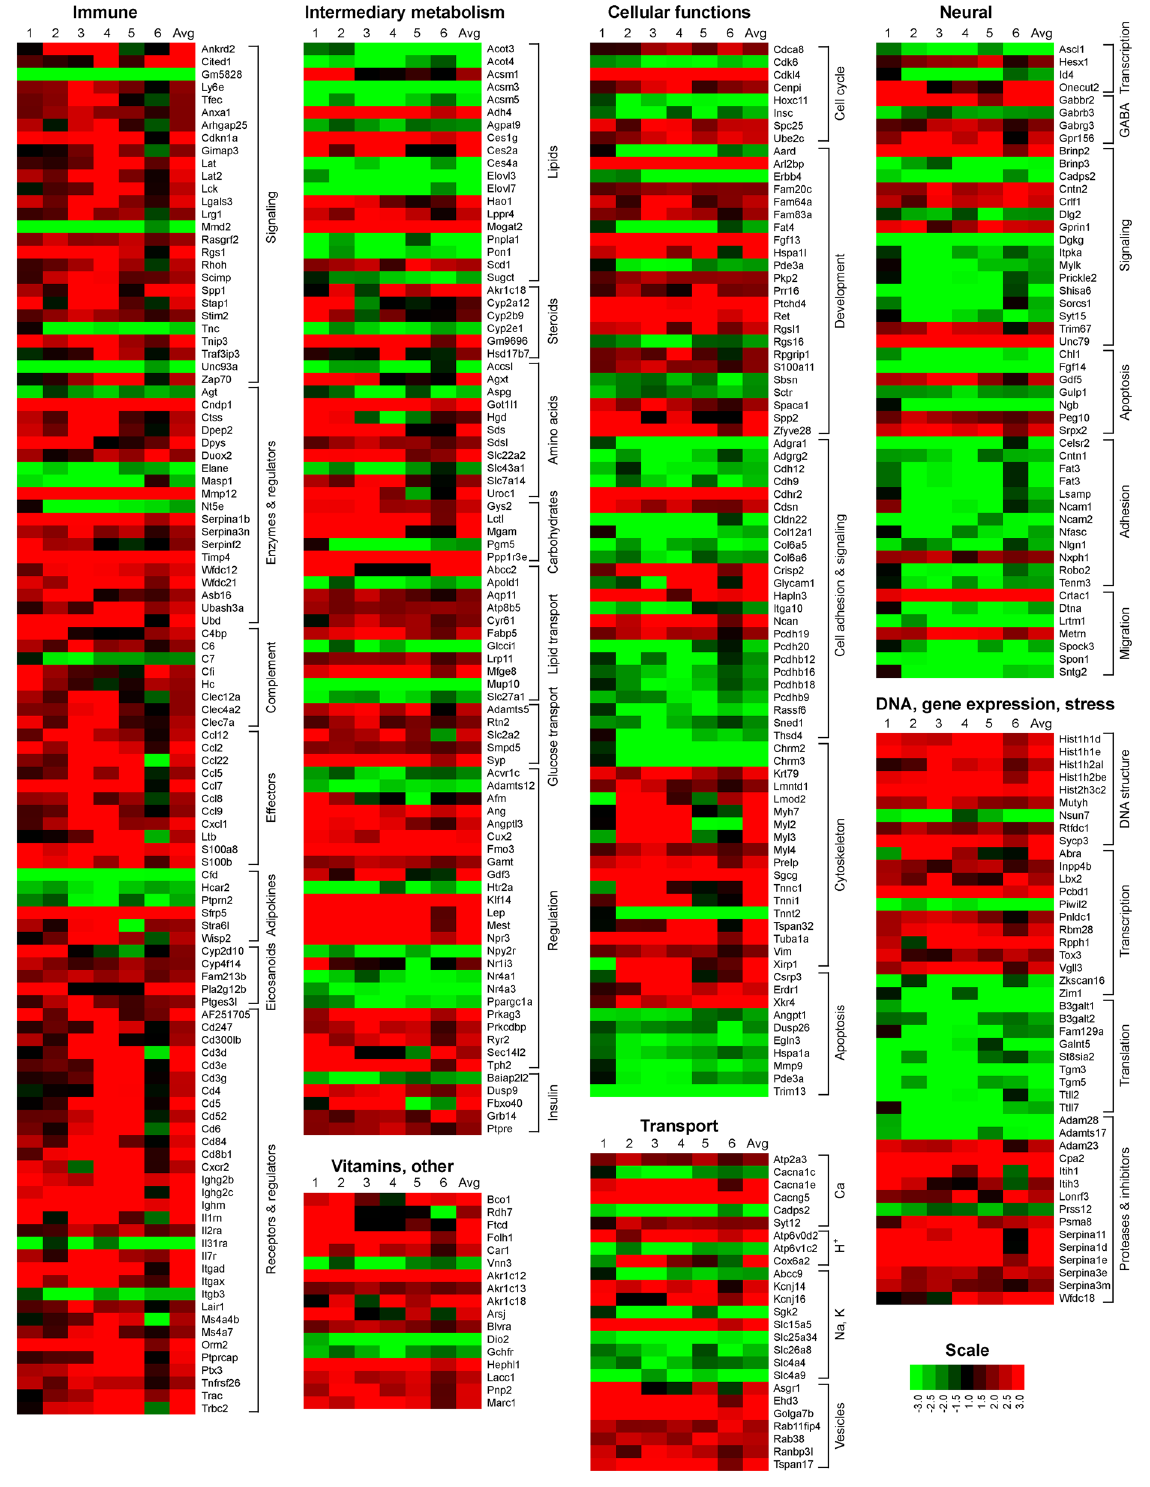
Figure 3. Differential expression of genes for immunity, metabolism, and other cellular functions in the adipose tissue of Nod2 − / − mice on HFD. Heatmap representation of the fold increase (red) or decrease (green) for gene expression in the adipose tissue of Nod2 − / − HFD mice compared with WT HFD mice. The genes are grouped based on function or pathway. The fold ratio for individual Nod2 − / − HFD mice to the average of WT HFD mice was computed and is shown (lanes 1 to 6) with the average of the fold for all Nod2 − / − HFD mice. Genes that had a fold change of ≥ 2 or ≤ 0.5 ( ≤− 2) and P ≤ 0.05 with 5% FDR are included in the heatmap. N = 6 mice/group. The numerical data for fold increase in individual mice, the average, P value, and FDR are shown in Supplementary Table